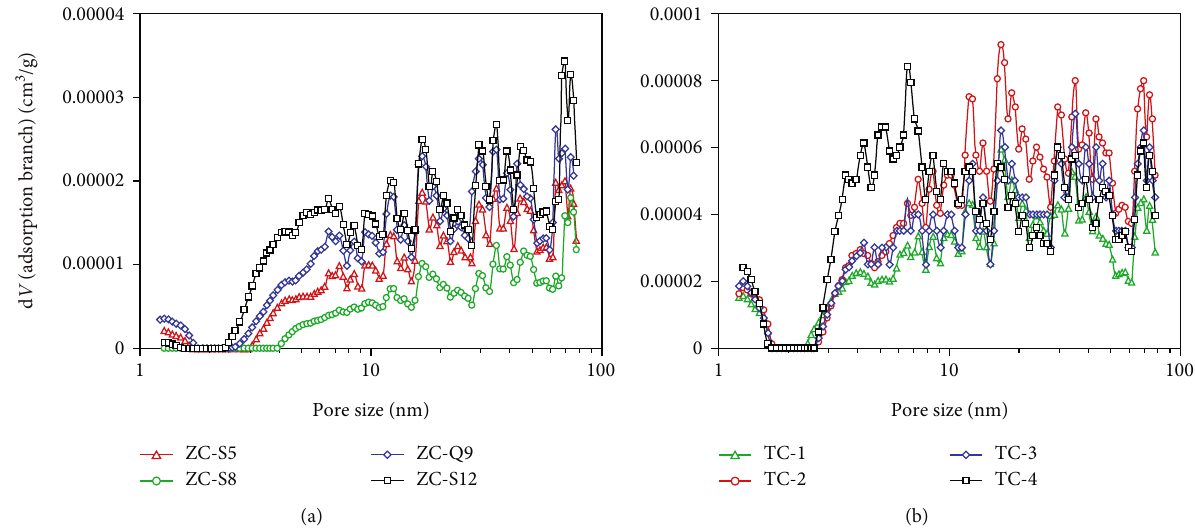
Figure 5: Relationship between incremental adsorbed volume and pore size for nonoutburst coal samples (a) and outburst coal samples (b).